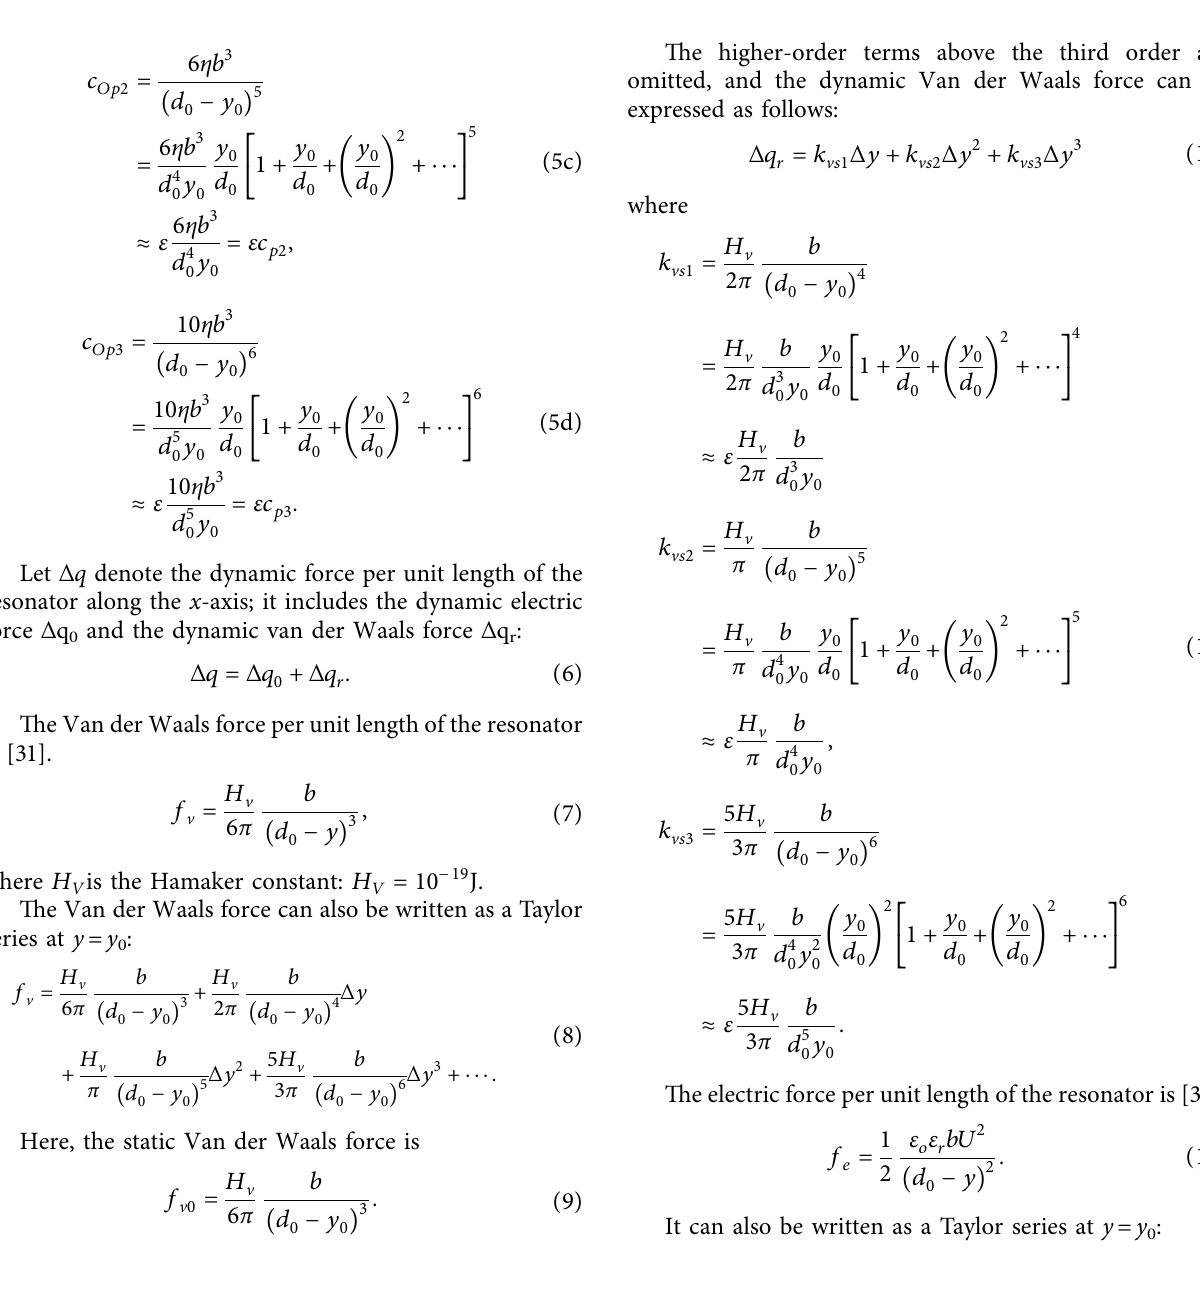
Figure 1: Coupled dynamics model of the